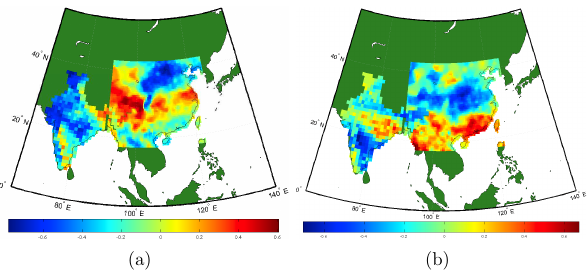
Fig. 3. Correlation maps between Joint PCs and rainfall field of China and India. (a) Joint PC1 vs. rainfall field of China and In- dia; (b) Joint PC2 vs. rainfall field of China and India.